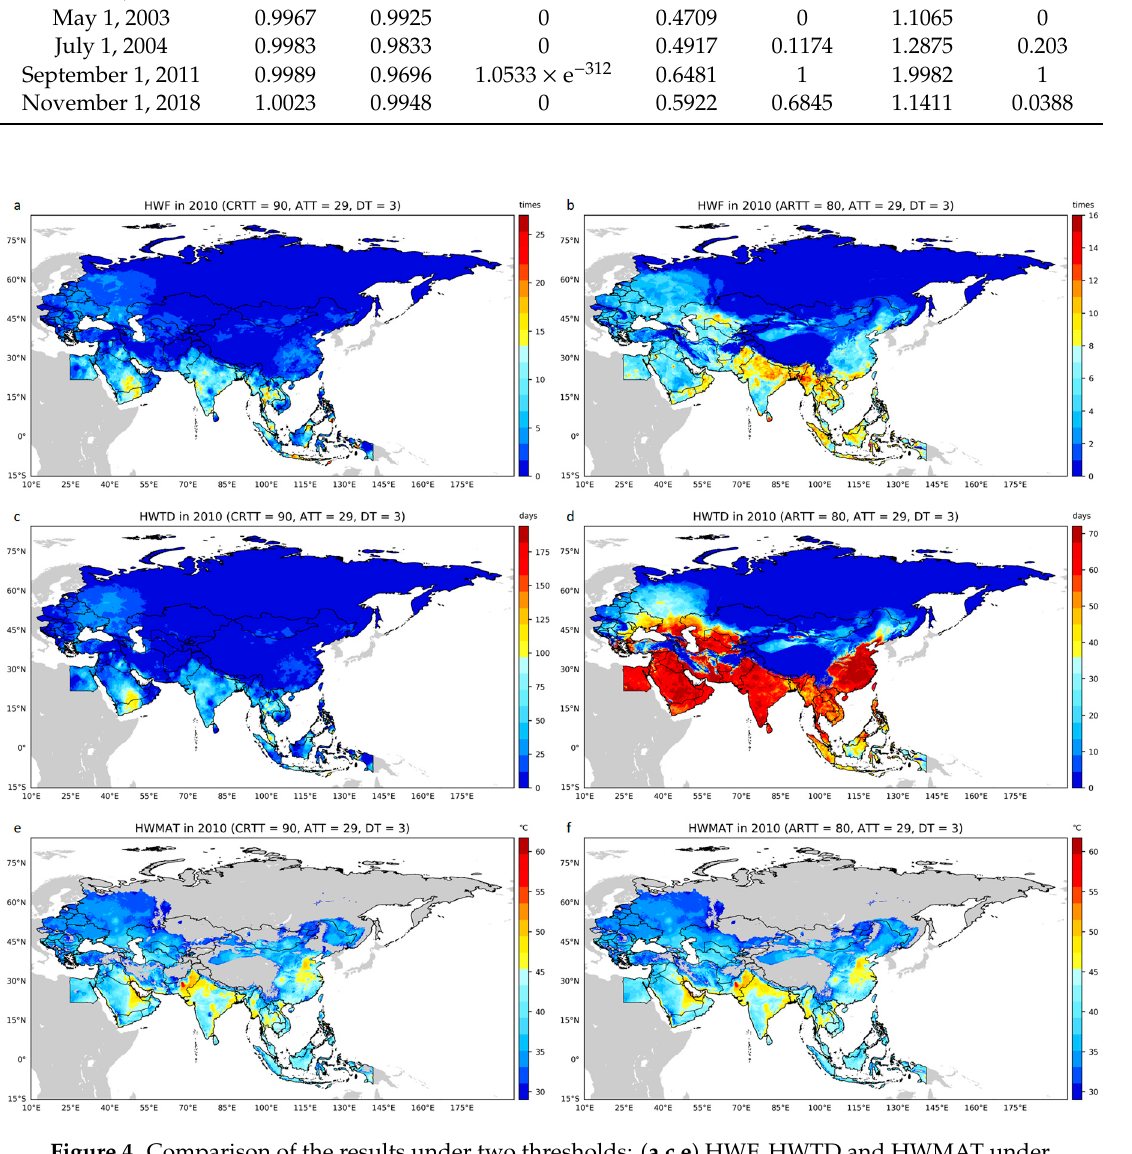
Figure 4. Comparison of the results under two thresholds: ( a , c , e ) HWF, HWTD and HWMAT under CRTT = 90; ( b , d , f ) HWF, HWTD and HWMAT under ARTT = 80.